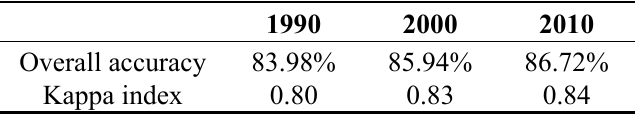
Table 4. Classification accuracy.